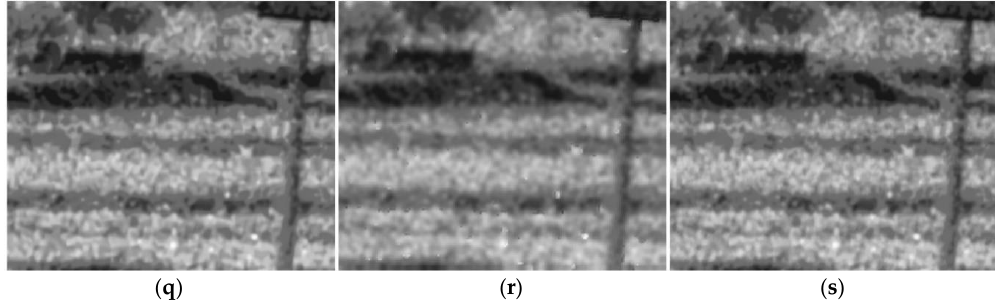
Figure 7. The subjective results of the proposed algorithm and other baselines. ( a ) the patches in the noisy ICCD image; ( b , h , n ) the result of the denoising algorithm in [2]; ( c , i , o ) the result of the proposed algorithm; ( d , j , p ) the result without the RPCA in Section 4.5; ( e , k , q ) the results of BM3D; ( f , l , r ) the result of K-SVD; ( g , m , s ) the results of BLS-GSM.